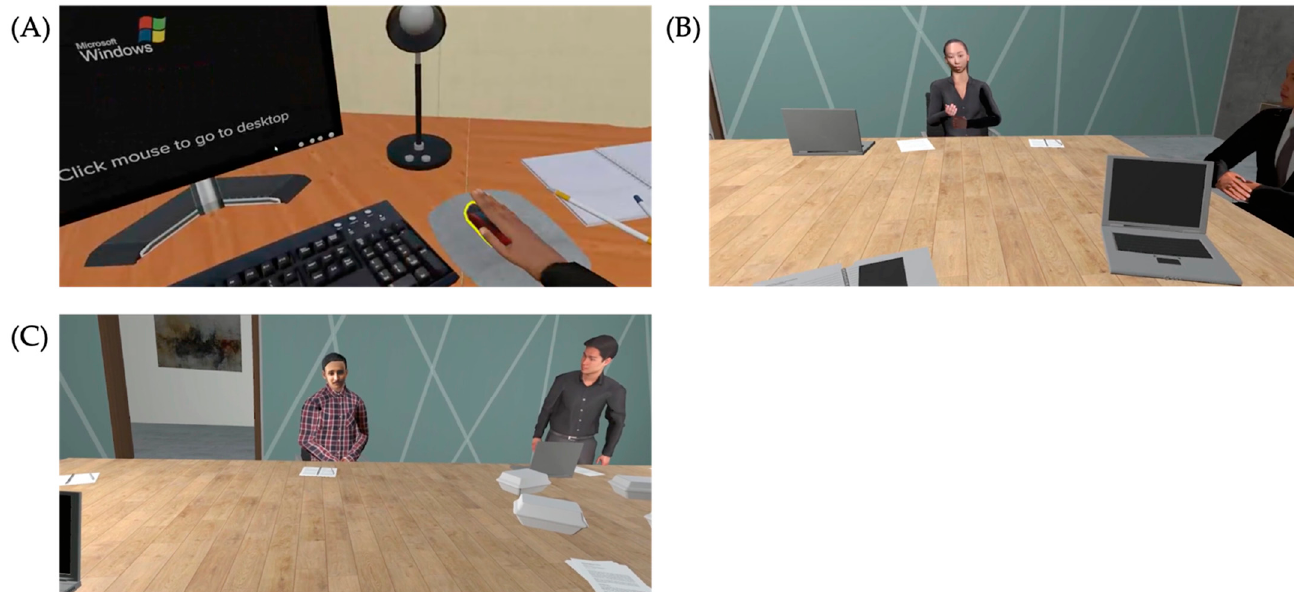
Figure 1. Screenshots depicting ( A ) scene 1, ( B ) scene 2, and ( C ) scene 3 in Study 1 (first-person perspective). Procedure